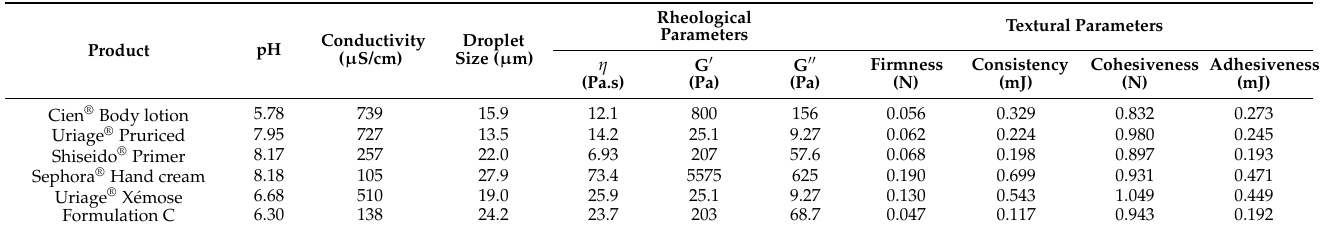
Table 4. Rheological parameters and textural parameters of commercial products tested. Apparent viscosity ( η , measured at 2.30 s − 1 ) and viscoelastic parameters (G (cid:48) , G (cid:48)(cid:48) ) measured at room temperature (~20 ◦ C). G (cid:48) -storage/elastic modulus and G (cid:48)(cid:48) -loss/viscous modulus, at f = 0.1